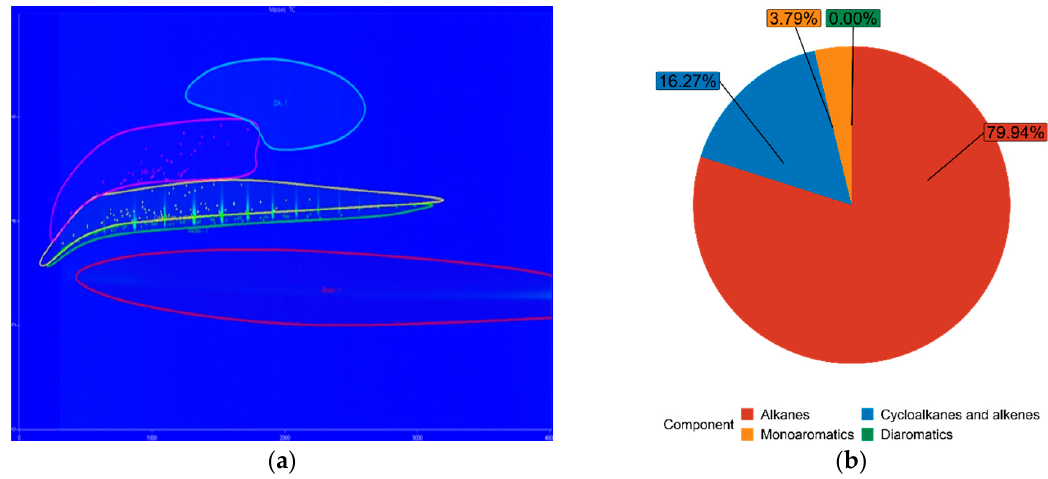
Figure 14. ( a ) Output of GC × GC-TOFMS for 30% FT − diesel; ( b ) hydrocarbon composition of 30% FT − diesel.